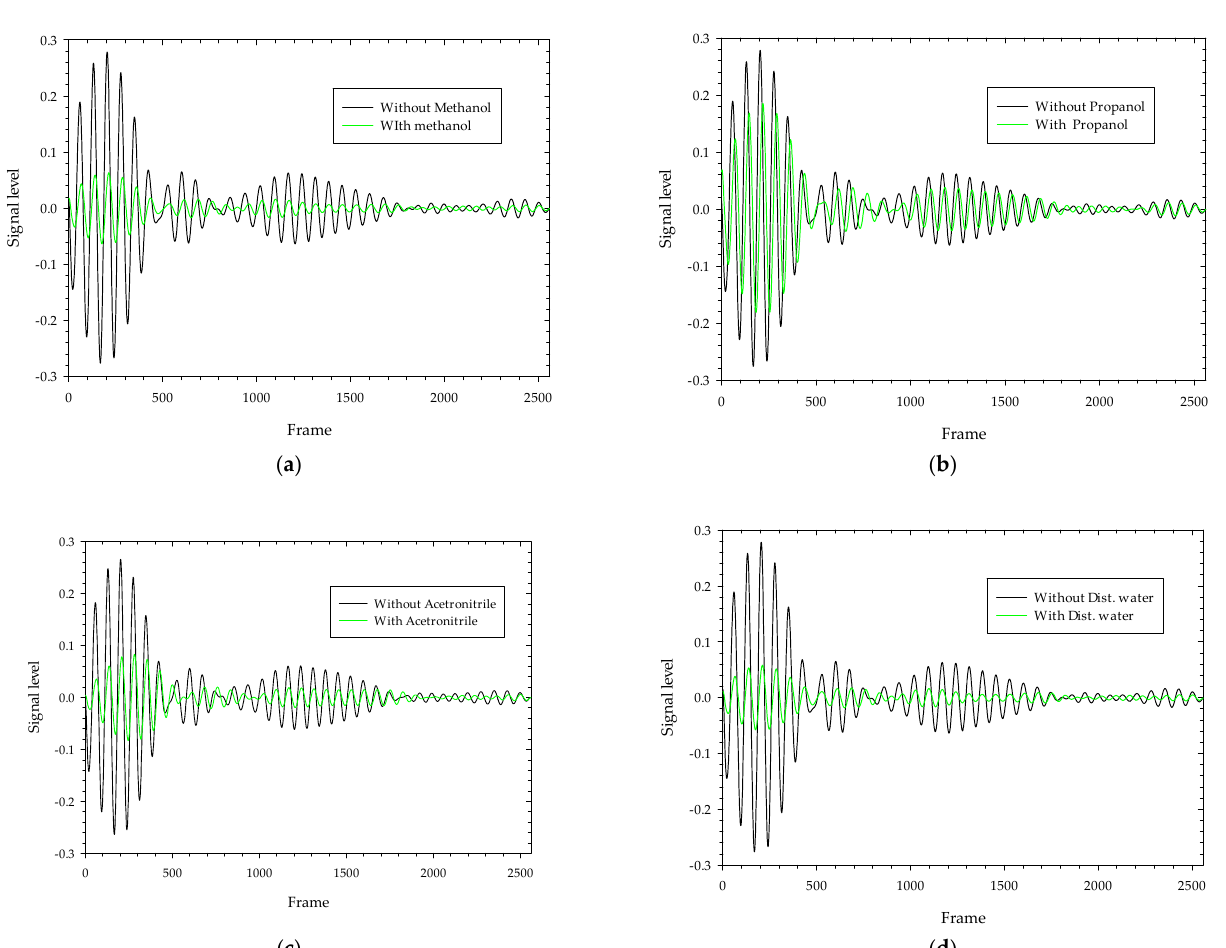
Figure 11. Resampled correlated received pulse signals with and without MUT at 5.3 GHz trans- mission using podal antenna: ( a ) Methanol; ( b ) Propanol; ( c ) Acetonitrile; ( d ) Distilled water.